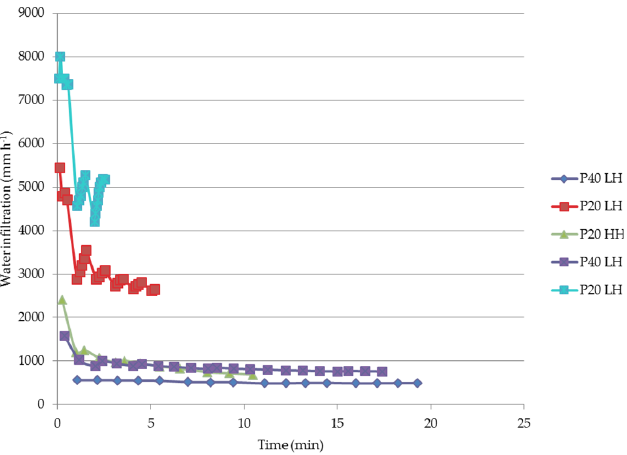
Figure 3. Soil water infiltration rate.